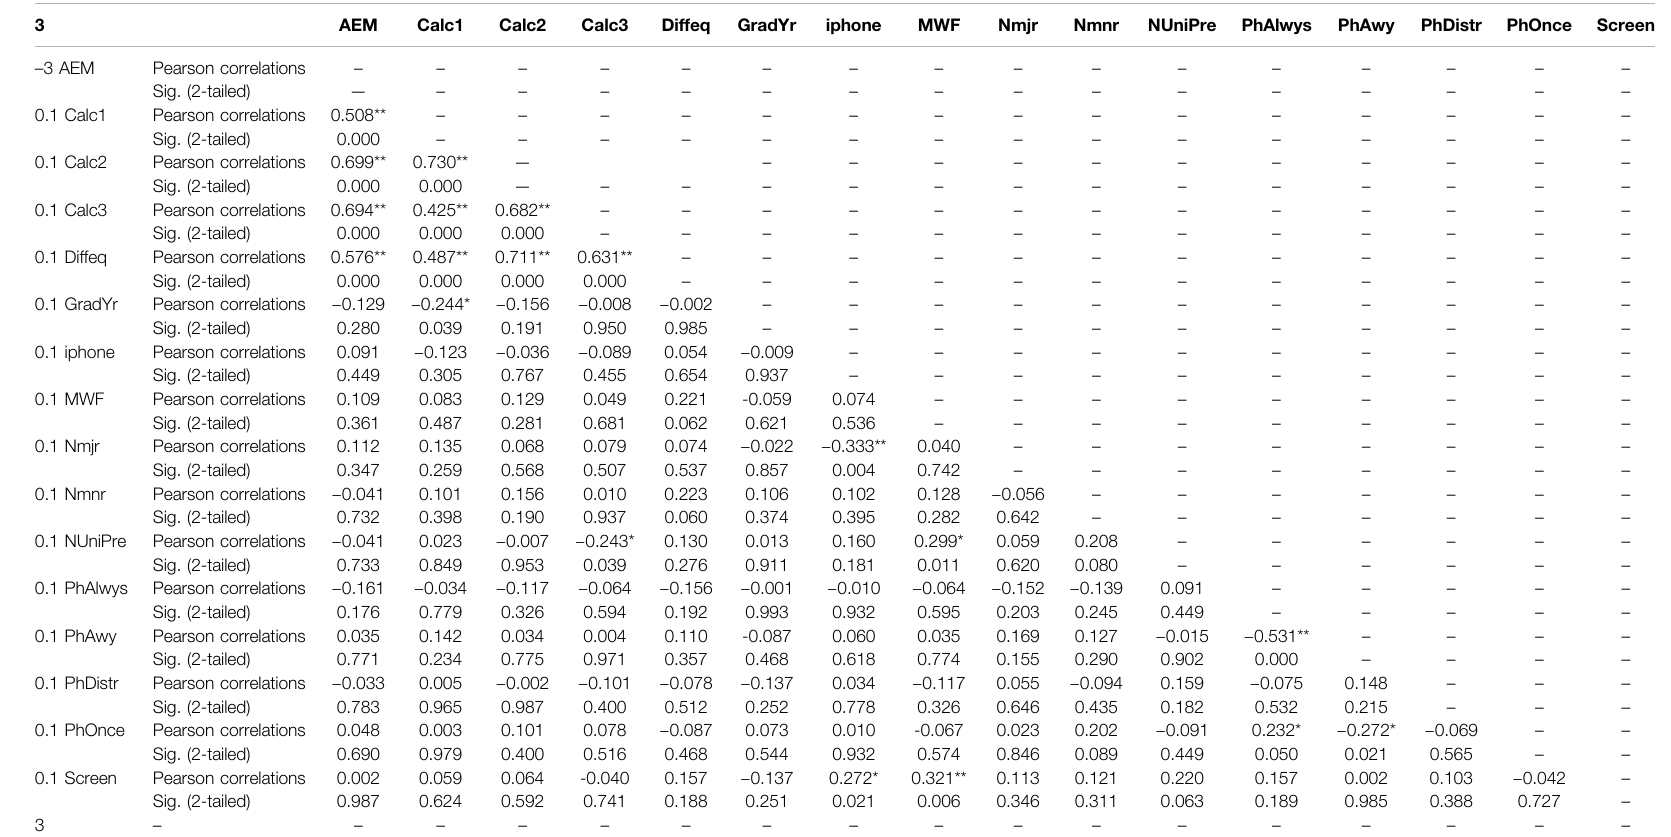
TABLE 2 | Pearson correlations between variables used in the study and their signi fi cance